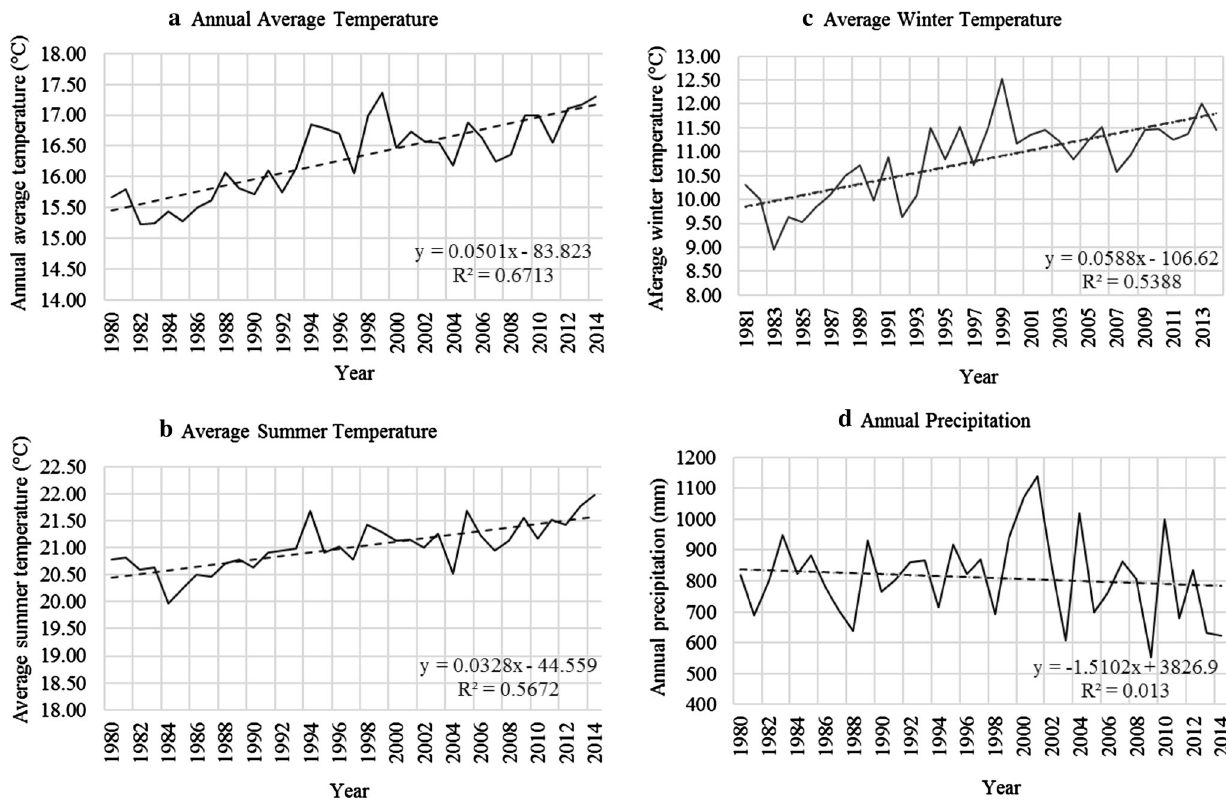
Fig. 5 Average a annual, b summer, and c winter temperatures, and d annual precipitation, for the period 1980–2014 for Longyang